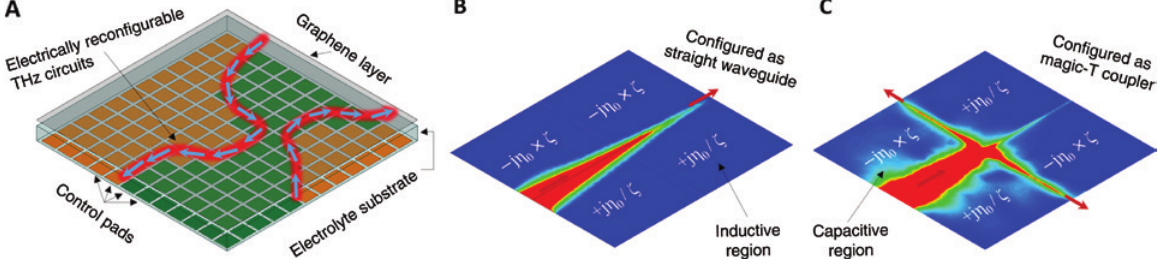
Figure 7: Illustration of an electrically programmable platform of line waves for (A) guiding signals along arbitrary-shaped pathways, (B) robust straight delay lines with tunable phase shift capability, and (C) network circuits such as a magic-T coupler based on spin-filtered